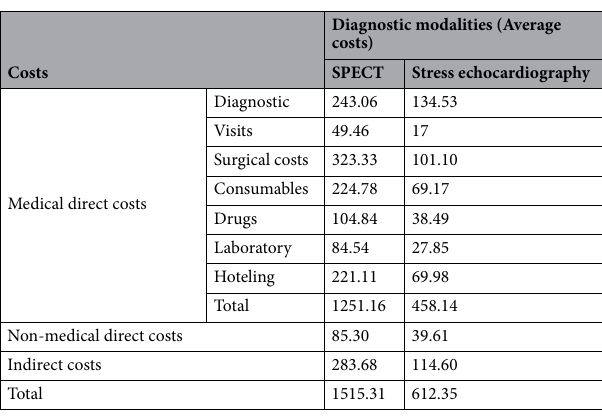
Table 2. The cost items for CAD diagnosis and treatment.